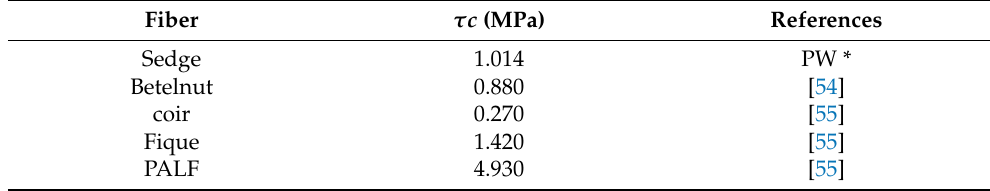
Table 6. Comparison of sedge fibers interfacial strength with different NLFs embedded in epoxy resins.